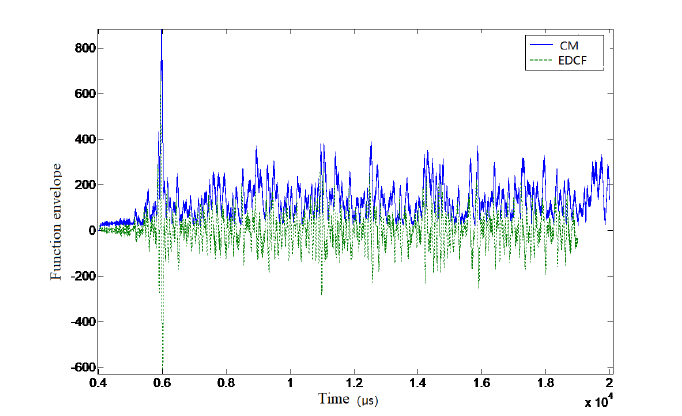
Figure 10. The correlation envelope function difference result in test data.